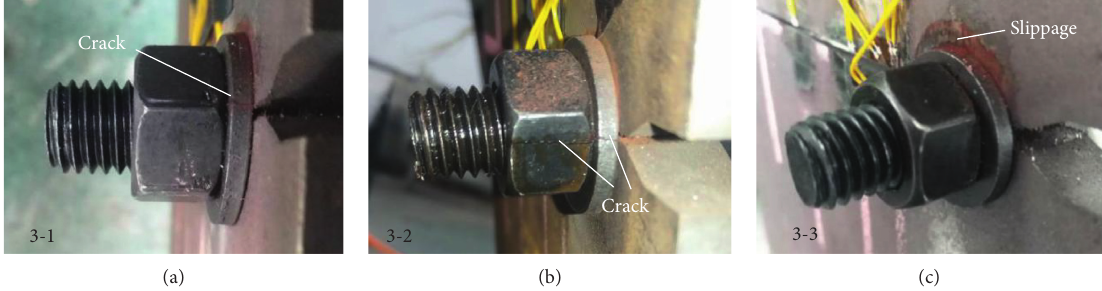
Figure 19: Observation of Group 3 during fatigue test. (a) Fatigue crack of washer. (b) Fatigue crack of washer and nut. (c) Slippage of washer.